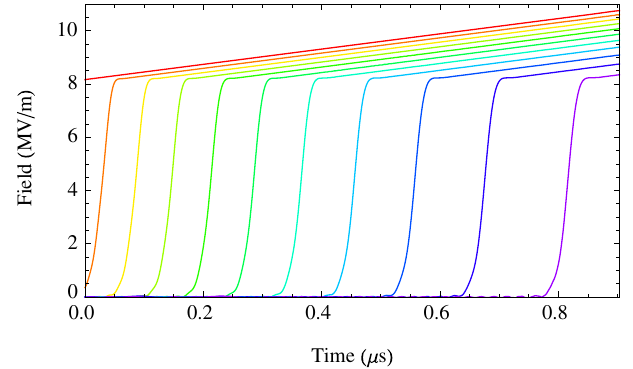
FIG. 5. Electric field as a function of time traced out at fixed positions along the linac. The uppermost (red) trace is at z ¼ 0 and successive traces are at 0.5-m intervals ending at 5.0 m (violet). The rf drive is as shown in Fig. 4, tuned for 100-mA beam current. The uppermost (red) trace is the injected rf field ð 0 ; t Þ showing the linear ramp. There is no beam injected ^ E z during the time shown.